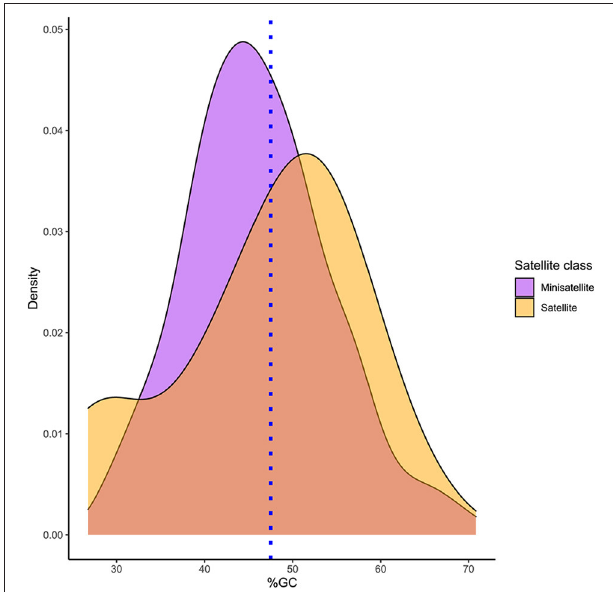
FIGURE 3 | Density plot representing the %GC distribution of P. leptodactylus minisatellite and satellite repeats. Blue line represents average %GC percentage of P. leptodactylus reported from the NGS